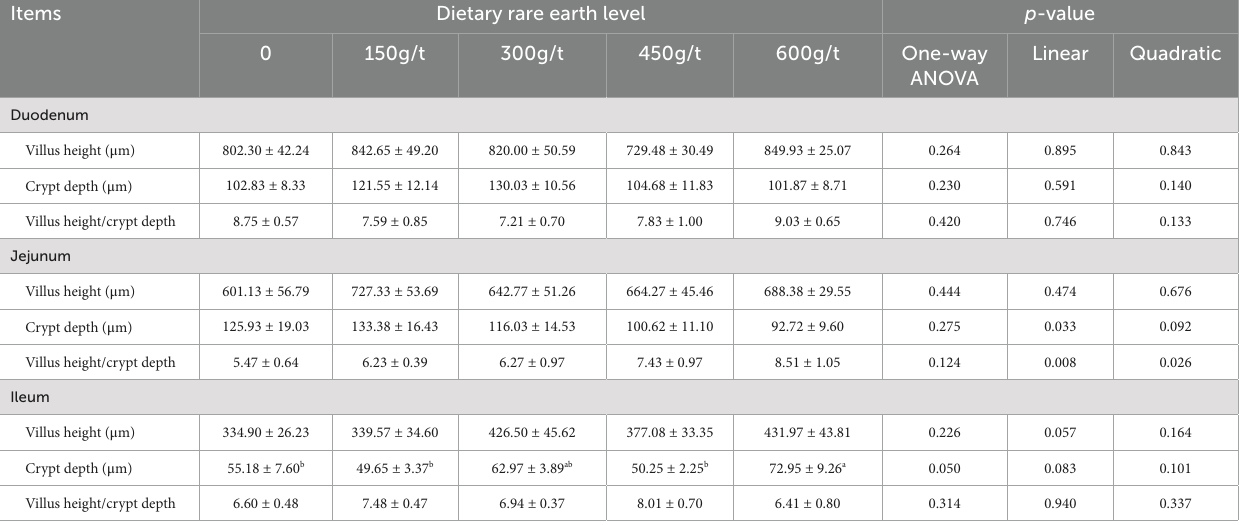
TABLE 6 Effects of dietary rare earth supplementation on the intestinal morphology of laying hens during the late laying stage ( n = 6). Items